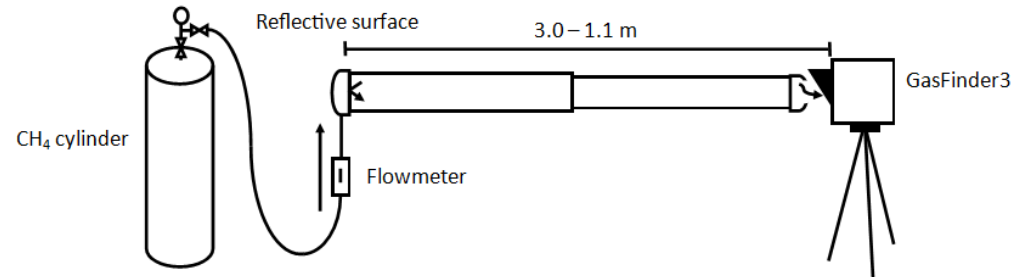
Figure 1. Diagram of the experimental setup indicating the standard gas cylinder, gas flow meter, telescopic cylinder with reflector on left side and open window on right side, and open-path laser. Tests occurred in the laboratory during the daytime between July 13th and August 12th, 2016.